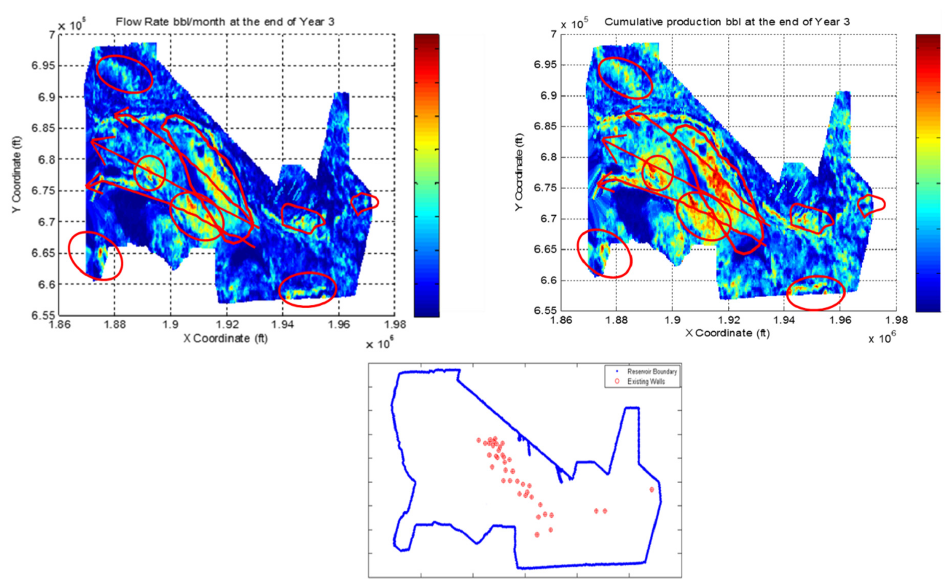
Figure 16. The sweet spots and permeability channels identified as a result of this study. The third insert in the bottom shows the wells that were put on production during the initial development stage of the field.